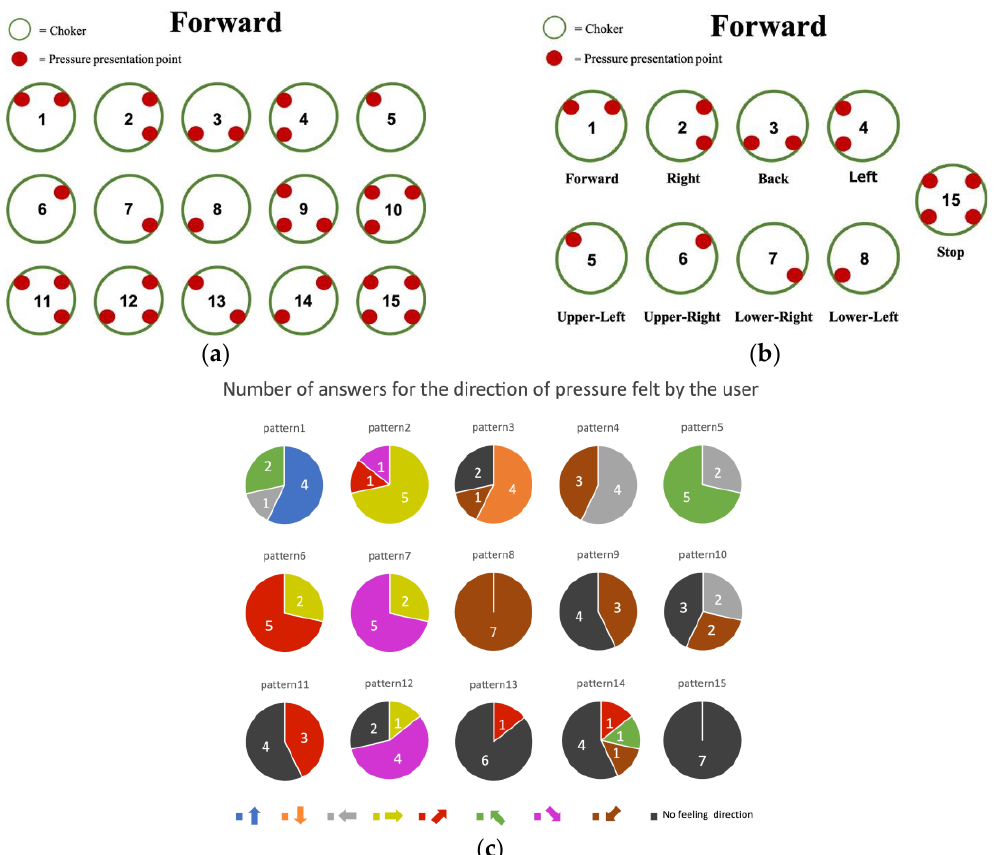
Figure 5. Pressure patterns the proposed device can present. The number in the graph is the number of subjects who responded in that direction. ( a ) Pressure patterns used in the preliminary study. ( b ) Pressure patterns used to indicate directions in the user study. ( c ) Results of Preliminary Study. The numbers in the graph indicate the number of answers. For each direction, the pattern with the highest number of answers was assigned that direction.